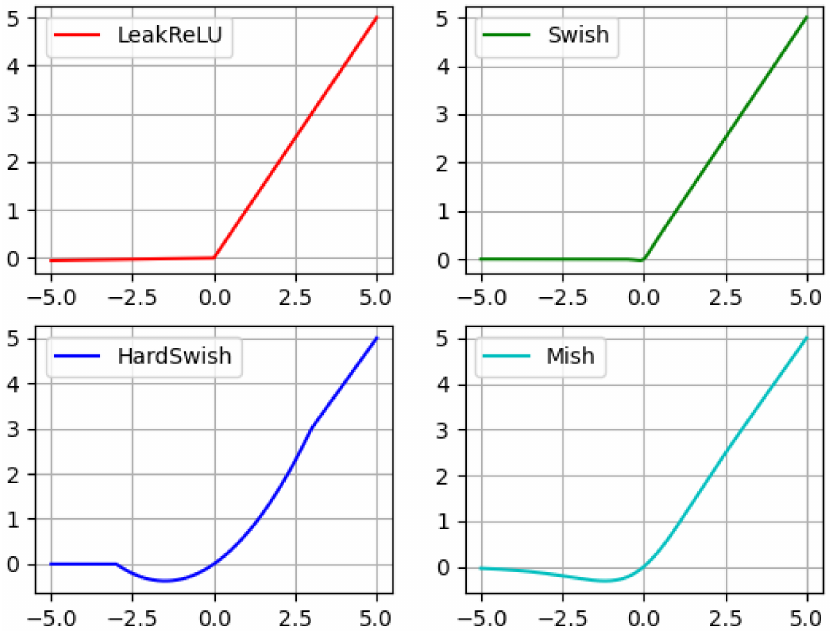
Figure 2. Mathematical models of Leaky ReLU, Swish, HardSwish, and Mish activation functions are compared